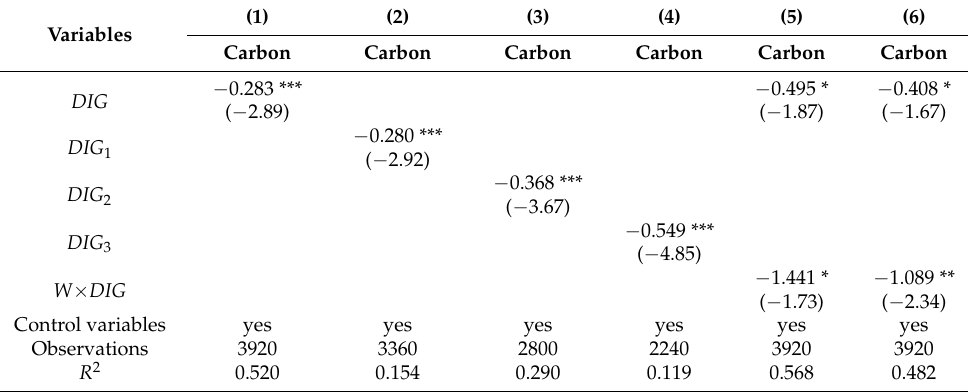
Table 7. Dynamic analysis and spillover